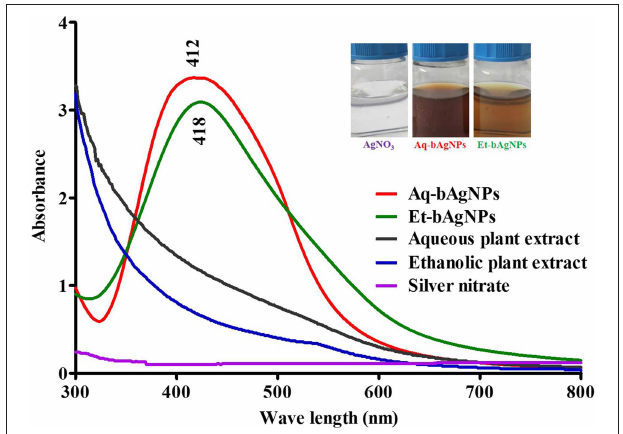
FIGURE 1 | UV-Vis spectra of biogenic silver nanoparticles